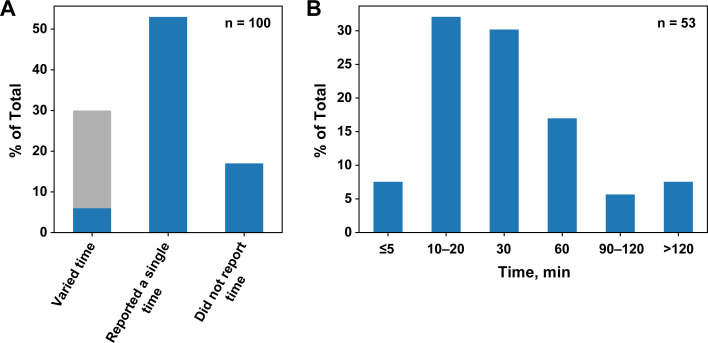
Survey of incubation times for published equilibrium dissociation constants.(A) Percentages of publications that did or did not report and vary the incubation time. The light gray portion of the first column indicates the studies using SPR and ITC, techniques in which time is varied by default. (B) Incubation times in papers that reported a single time.